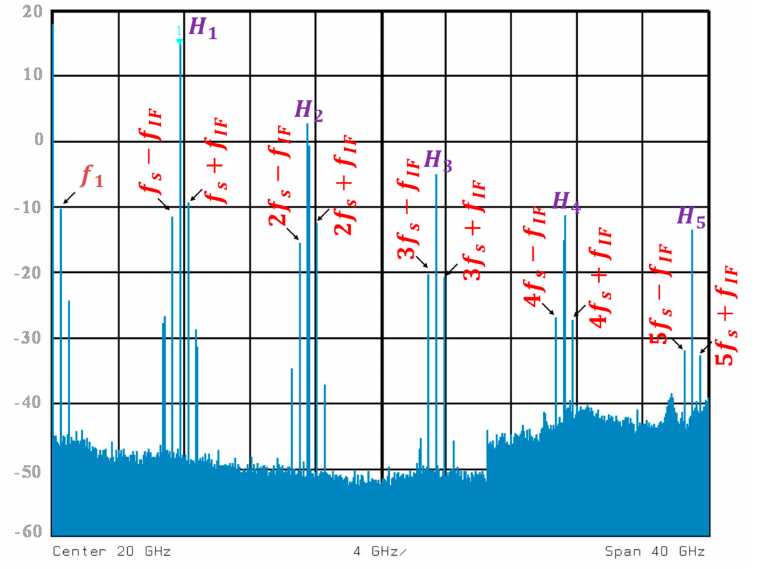
Figure 9. Electrical spectrum of the sampled signal for the experimental work at the MZM2 output at nf s ± f IF .